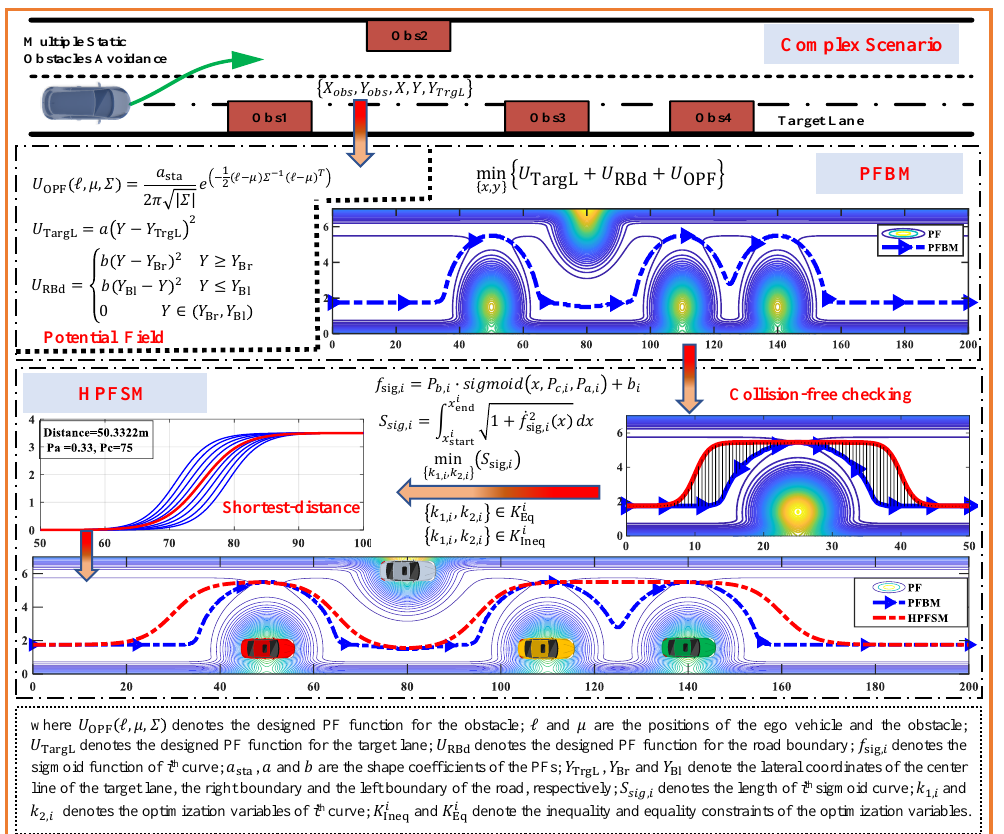
Figure 1. Framework of the hybrid path planning method by combining potential fields with sigmoid